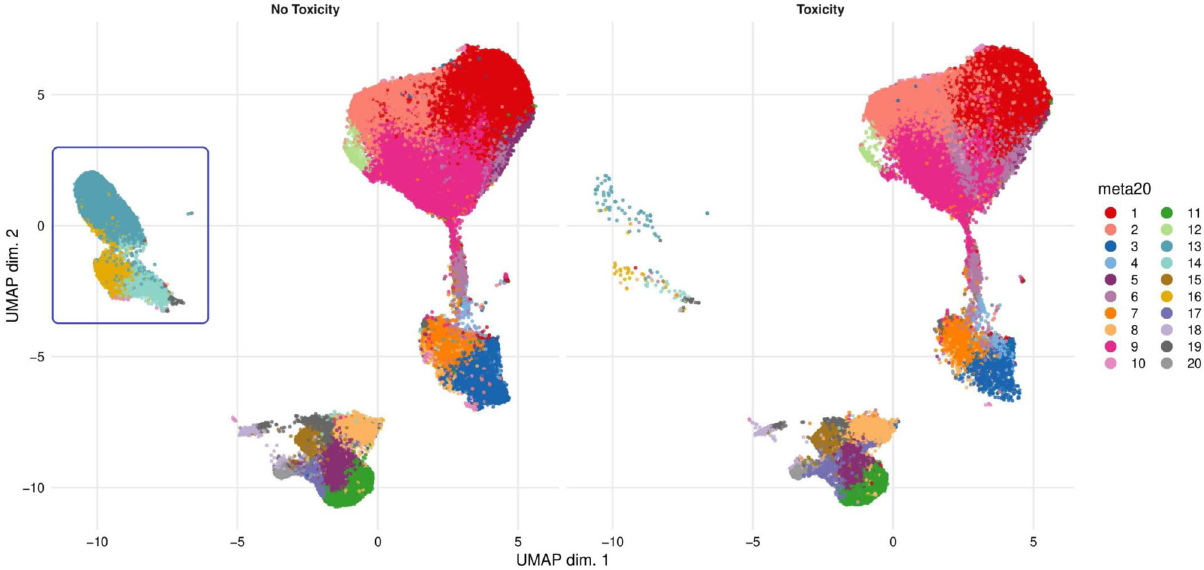
Fig. 5 Comparative analysis of B-cell populations between toxicity and non-toxicity cohorts with Breg/Tfh panel (panel 2). UMAP plots strati fi ed according to condition, “ no toxicity ” and “ toxicity ” . Clusters highlighted by blue boxes correspond to the most visually attenuated clusters in the “ toxicity cohort ” in this sub-analysis. These clusters are B10-type and PD-1 + in nature thus phenotypically similar to those identi fi ed in the previous analysis. All samples are randomly downsampled to account for equally representative populations across